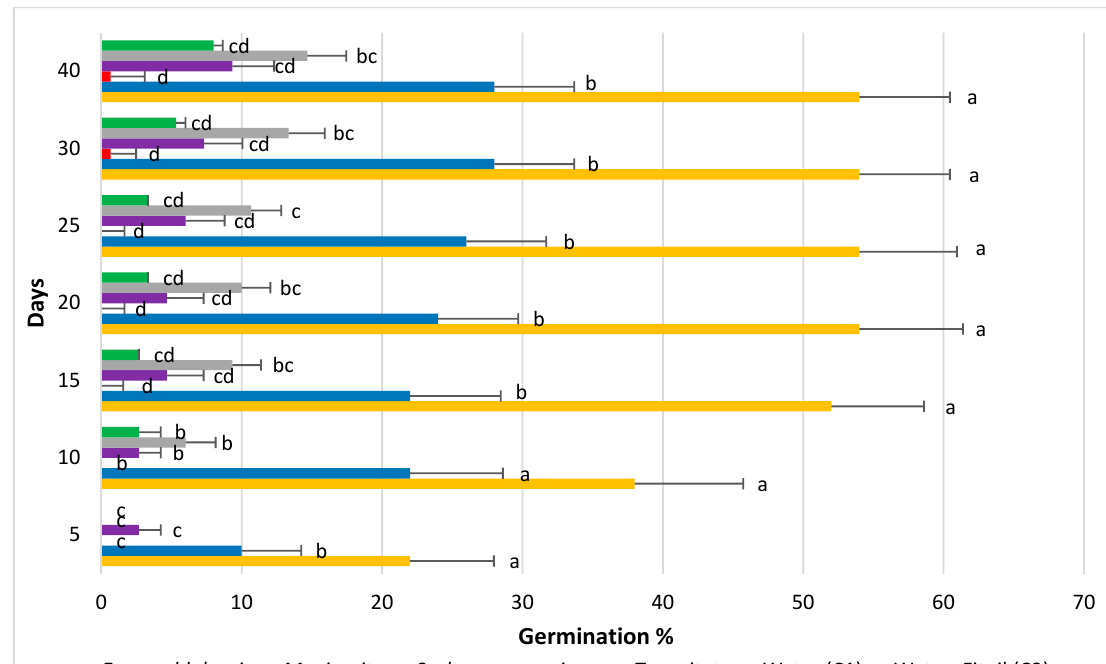
Figure 1. Percentage of seed germination in Erigeron bonariensis exposed to four EOs, compared with two controls (C1, water and C2, water + Fitoil). Error bars correspond to the standard error of each mean. For each observation day, means followed by the same letter are not statistically different (Tukey’s test, P ≤ 0.05).